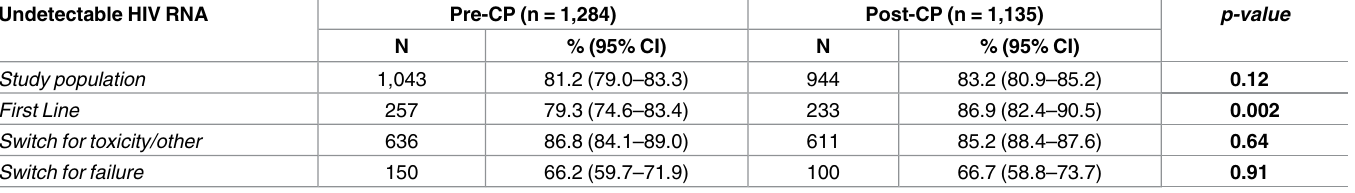
Table 3. Patients with undetectable HIV-RNA at 12-month follow up, Lombardy Region, Italy, comparing Pre-CP (2009–2010) and Post-CP (2011– 2012). Undetectable HIV RNA